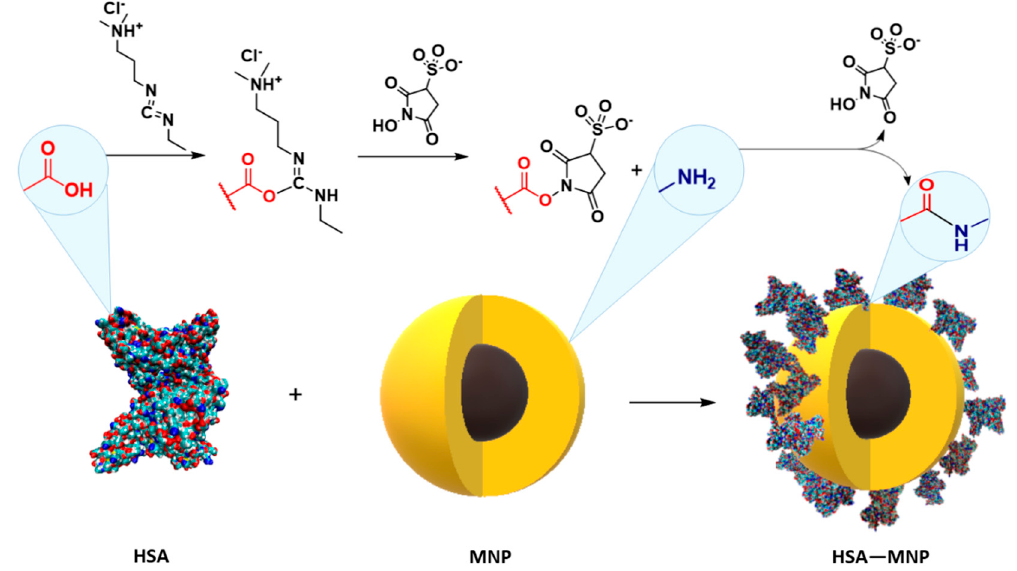
Figure 3. Scheme of human serum albumin (HSA) immobilization on magnetic nanoparticles (MNPs) surface .